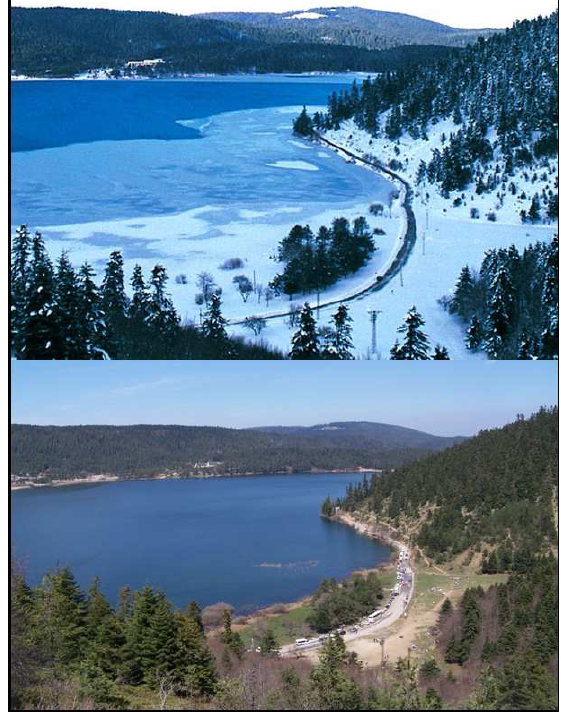
Figure 2. A vista point in BLANP in winter and summer